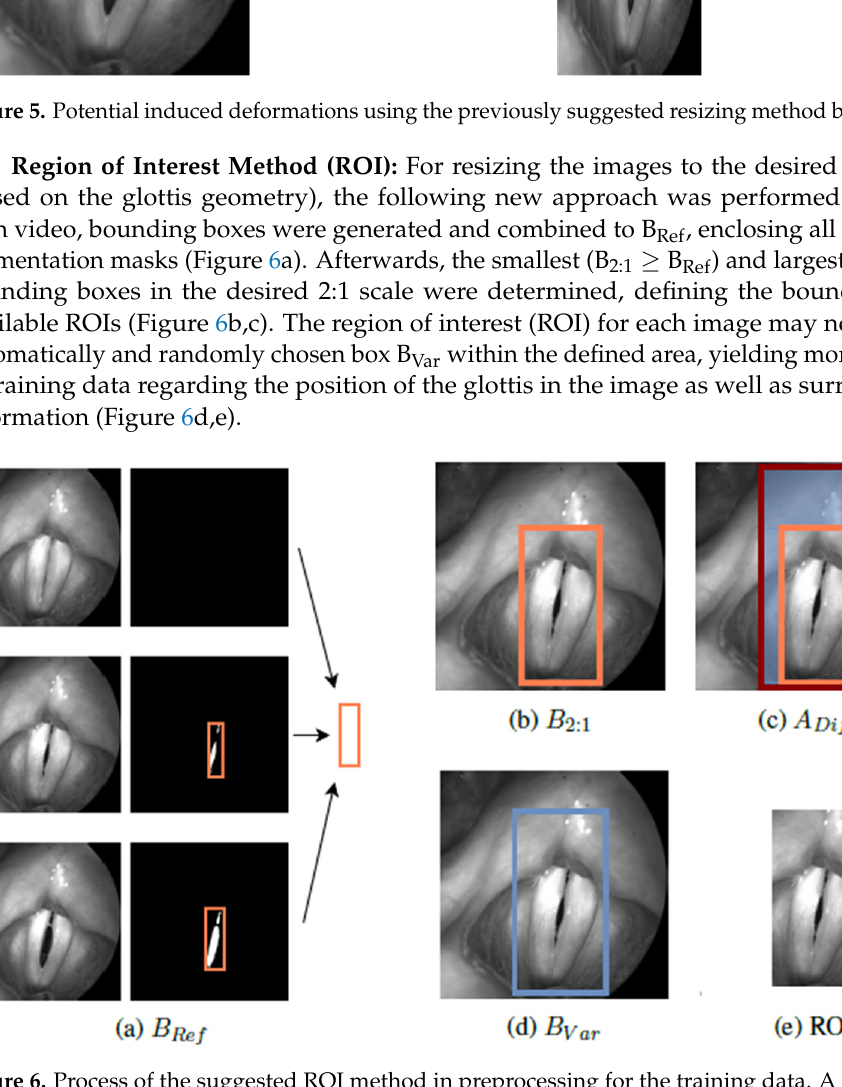
Figure 6. Process of the suggested ROI method in preprocessing for the training data. A randomly chosen ROI is presented in ( e ).